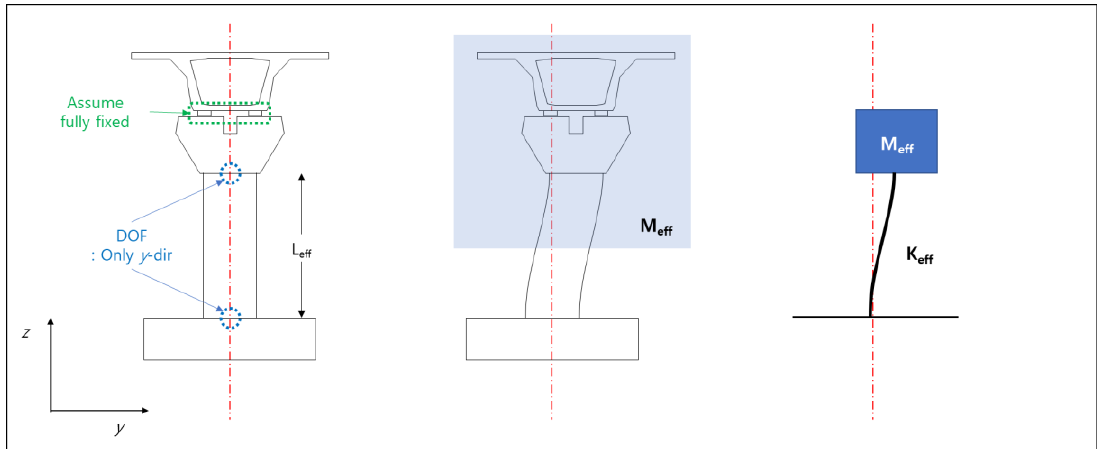
Figure 6. Diagram of bridge modeling (L eff , M eff , and K eff denote length, mass, and stiffness of the SDOF model, respectively).